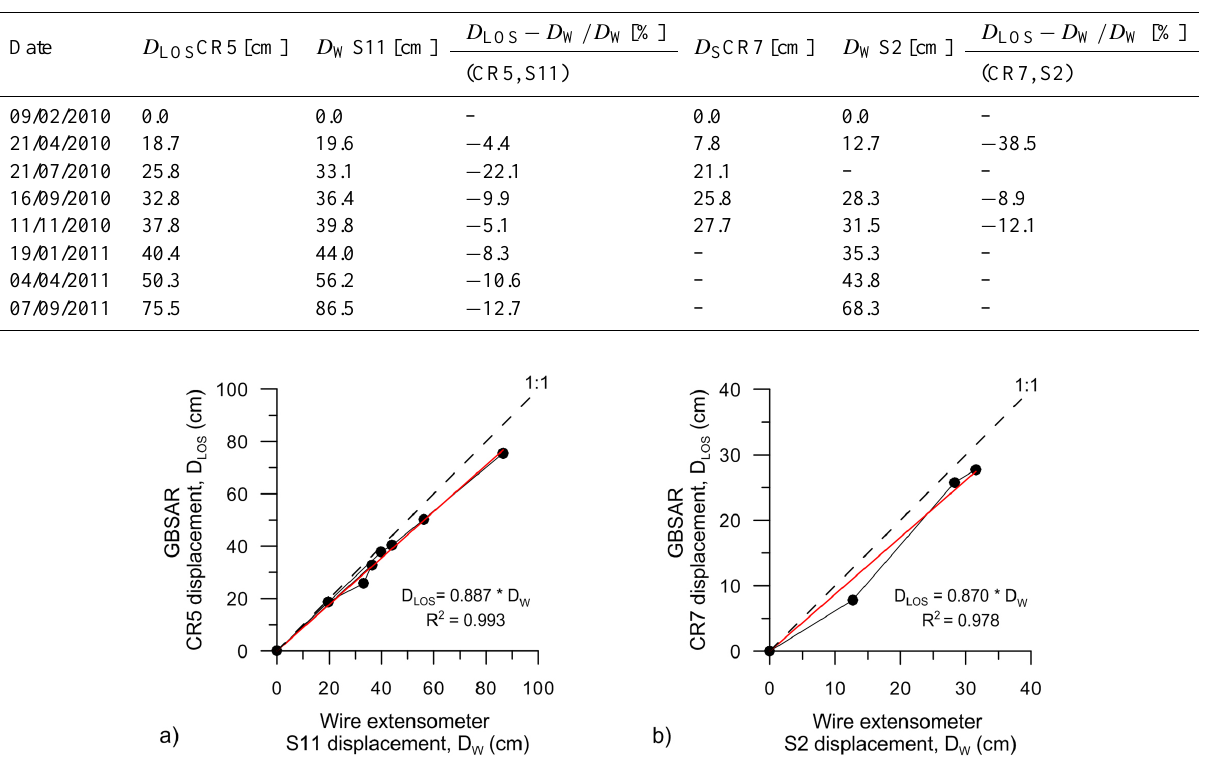
Table 3. Comparison of GB-SAR LOS displacements ( D LOS ) measured for CR5 and CR7 and total displacements measured by wire extensometers ( D W ) for S11 and S2, respectively.